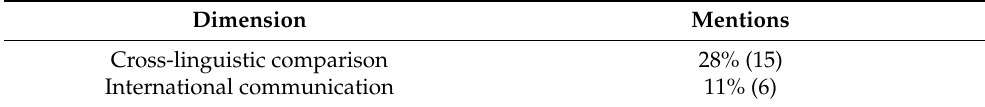
Table 12. Main dimensions of participants’ cognition about why to include other languages. Mentions are given as a percentage of the total number of participants, followed by the absolute number of mentions. More than one theme can be present in a single participant’s